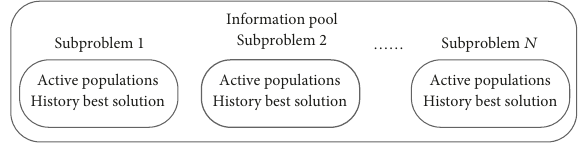
Figure 3: Demonstration of information